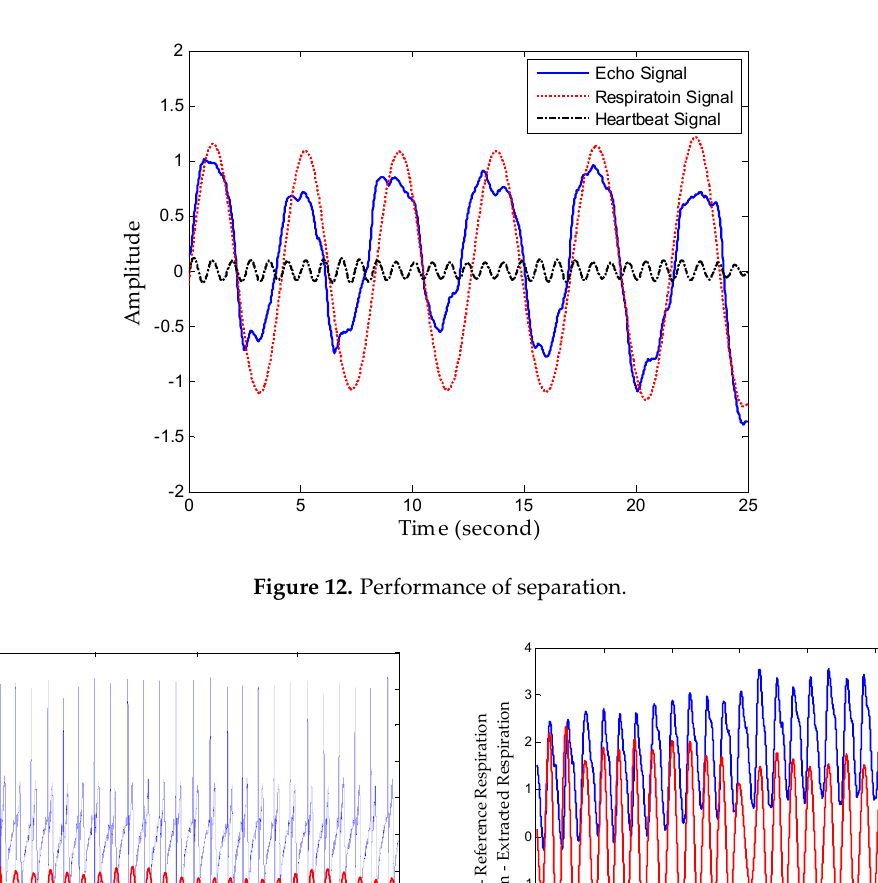
Figure 11. Performance of noise reduction. ( a ) Comparison of original vital sign signal with the denoised signal; ( b ) noise removed after denoising processing.